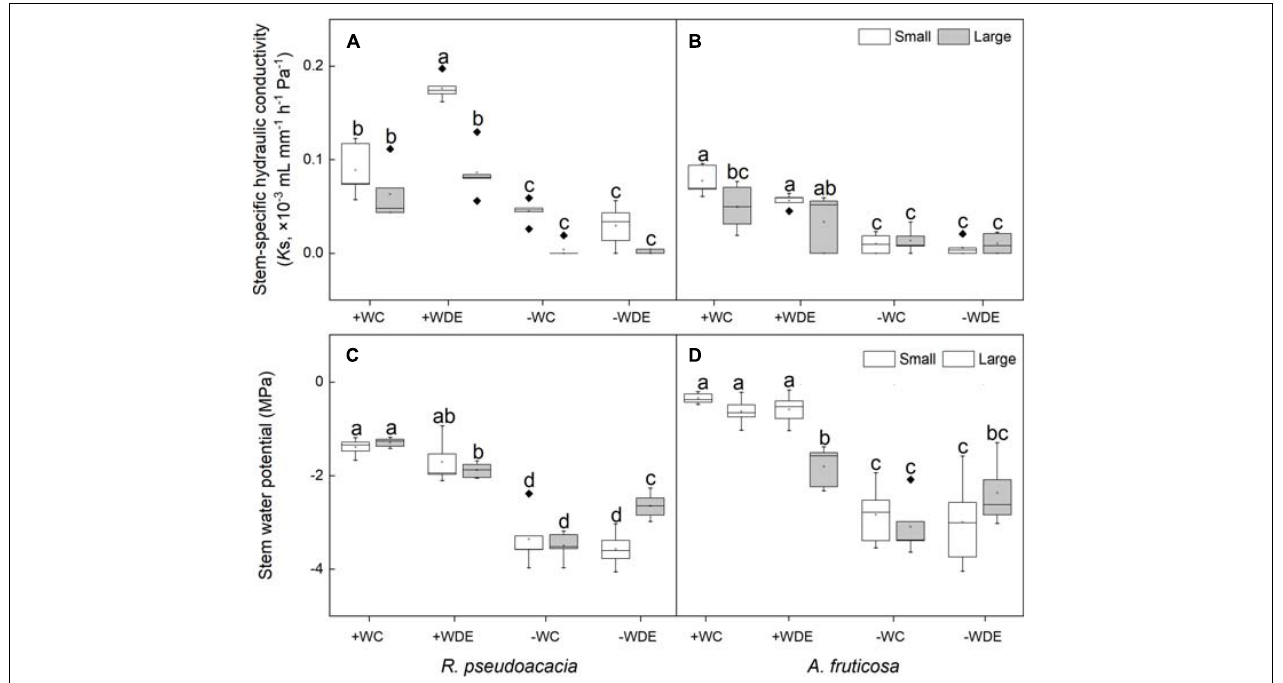
FIGURE 4 | Seedling stem-specific hydraulic conductivity and stem water potential of Robinia pseudoacacia (A,C) and Amorpha fruticosa (B,D) under different water availability and defoliation treatments for 60 days of two plant sizes. The values of the boxplot are the mean of five replicates. Different letters indicate significant differences among different defoliation treatments ( p < 0.05) according to Duncan’s test. +WC, high water availability without defoliation; +WDE, high water availability treatment with defoliation; –WC, low water availability without defoliation; –WDE, low water availability with